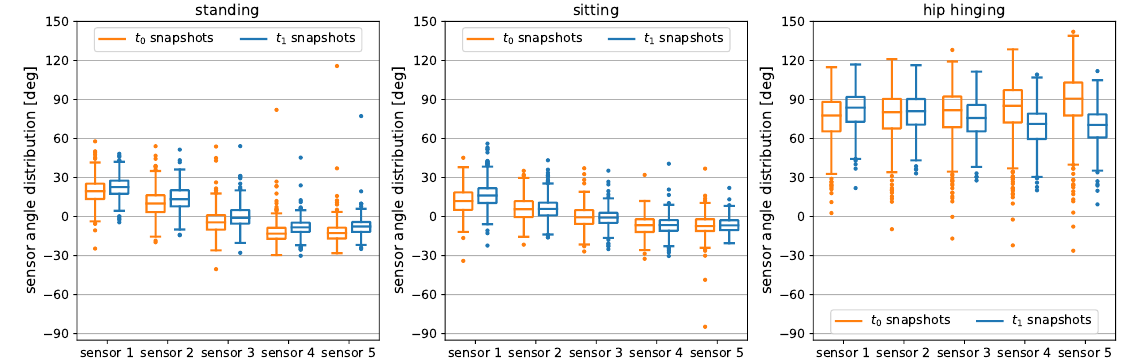
Figure 4. Boxplots of the angle distribution of the t 0 and t 1 snapshots grouped by sensor. The box frames the lower ( Q 1 ) to upper ( Q 3 ) quartile values of the data. The horizontal line inside each box marks the data’s median. Whiskers include data between Q 1 − 1.5 IQR and Q 3 + 1.5 IQR, where IQR = Q 3 − Q 1